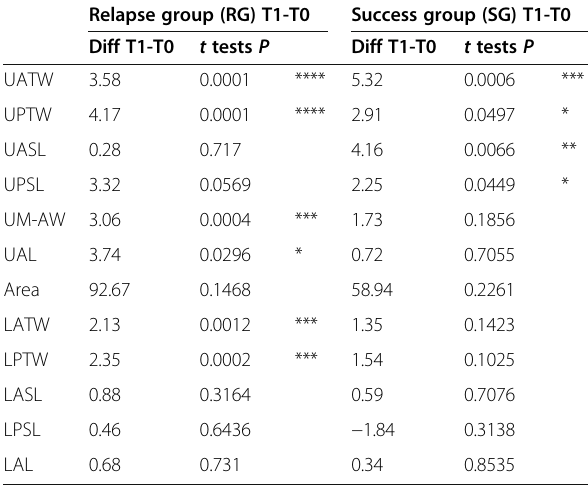
Table 7 Statistical comparisons of the T1-T0 changes in the RG and in the SG